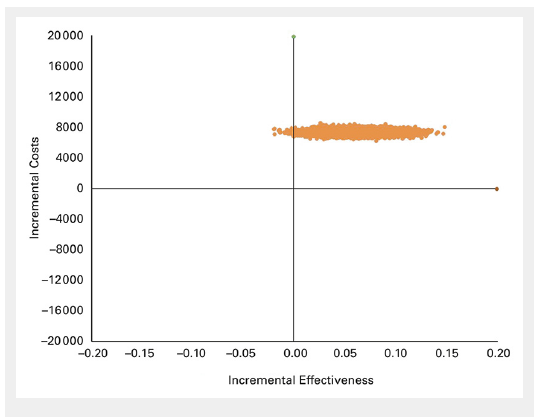
Scatter plot of incremental costs per person and incremental effectiveness derived from 10 000 iterations of the Monte Carlo simulation. Incremental effectiveness is expressed as quality adjusted life years (QALYs) gained and incremental costs are in CHF, from the healthcare system perspective.